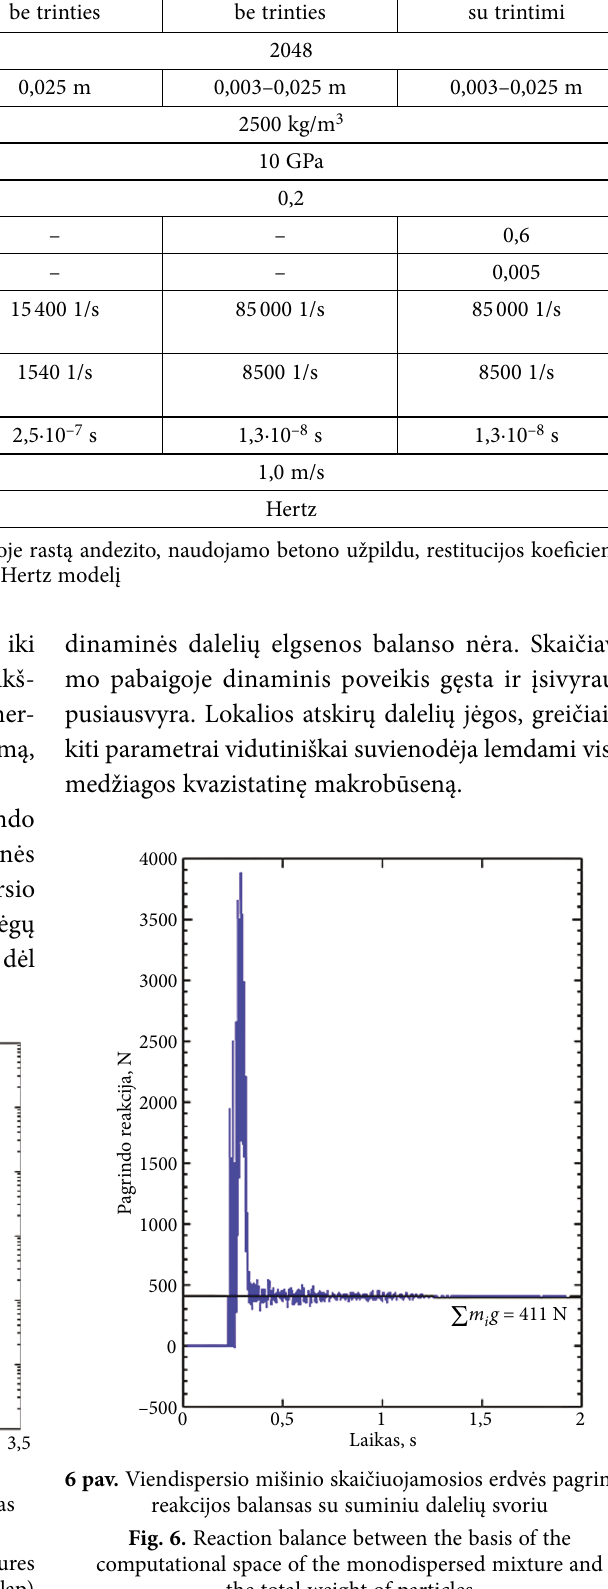
Fig. 5. Changes in the total kinetic energy of particle mixtures considering time (curves of the polydispersed mixtures overlap)